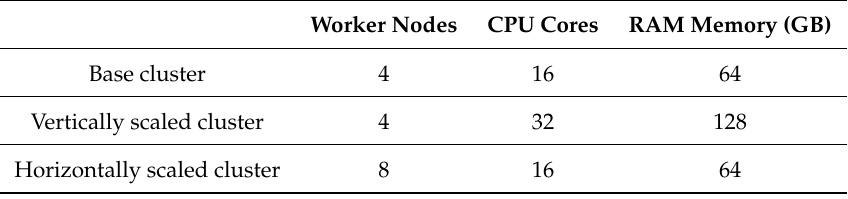
Table 2. Specifications of the three clusters with different computational resources used for the scalability